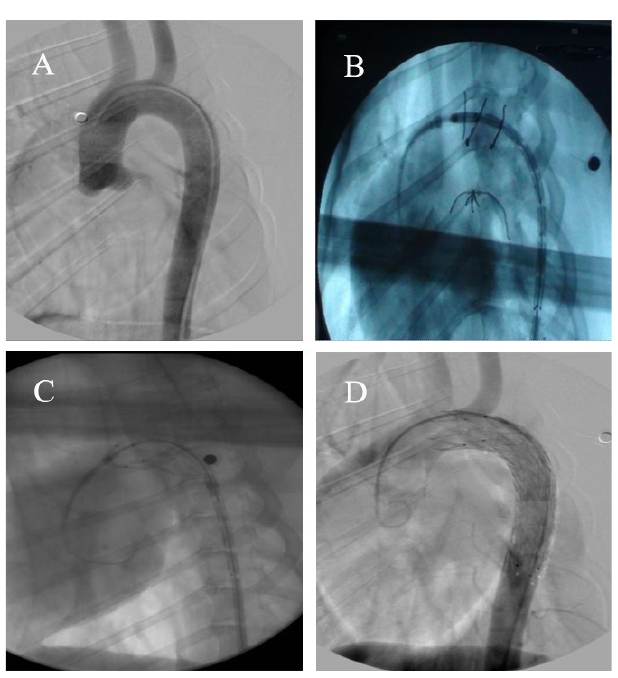
Fig. 2 - Angiography. (A) Preoperative angiography image. (B) The delivery system reached the present position. (C) The release of stent- graft firstly. (D) Postoperative angiography